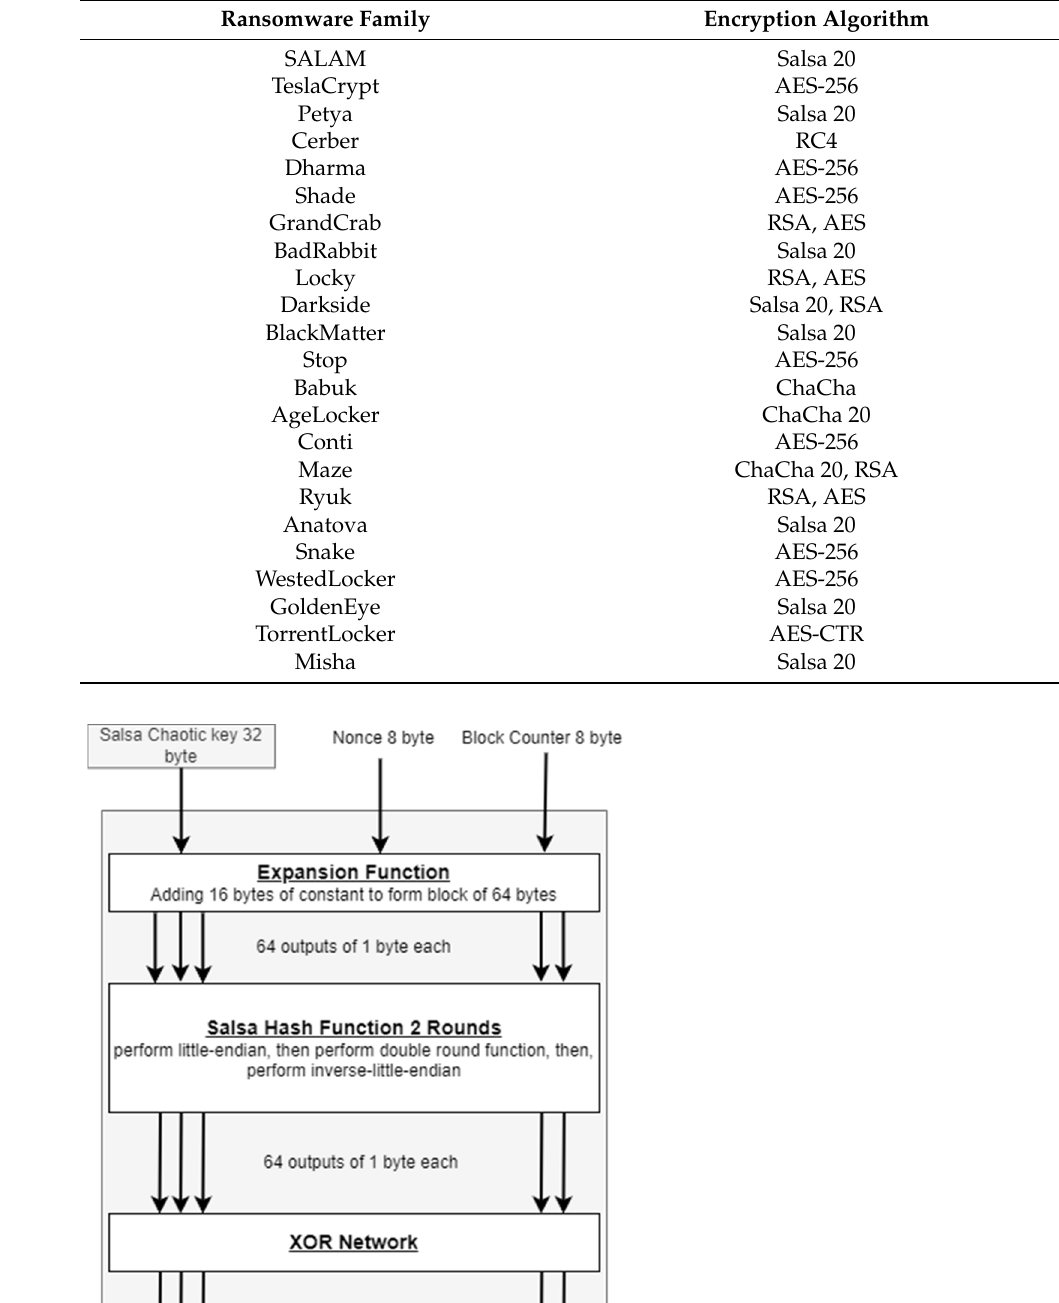
Table 5. Ransomware Encryption Algorithms [28–30].